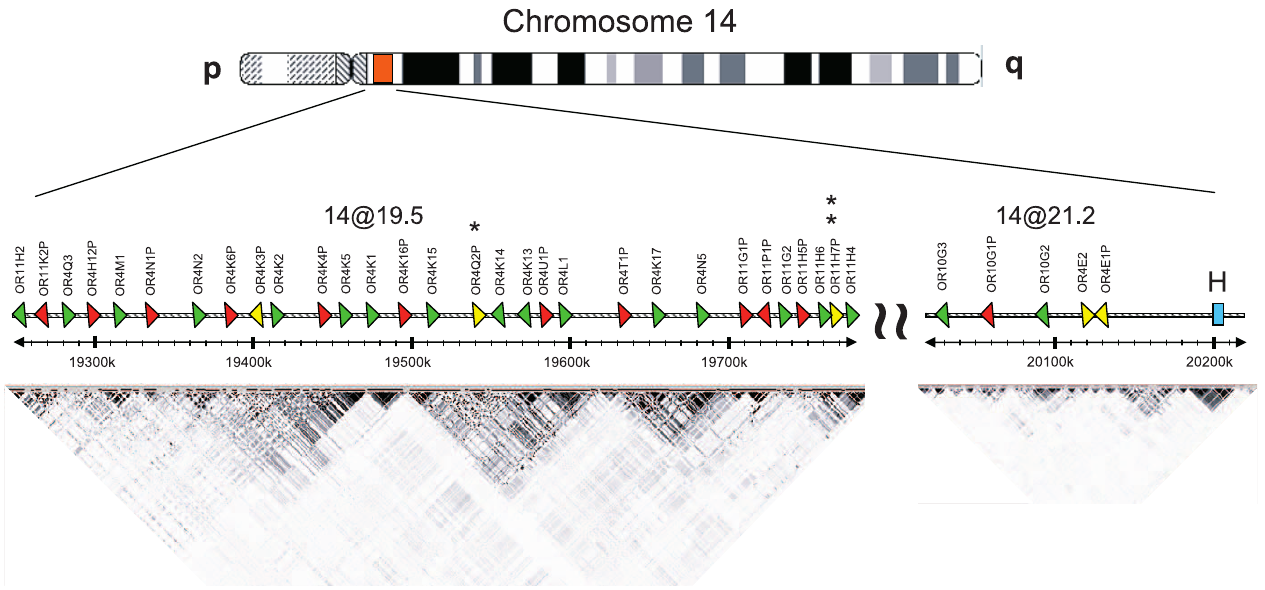
Figure 3. The Genomic Region Associated with IVA Hyperosmia OR genes are represented by red, green, and yellow triangles indicating pseudogenes, intact genes, and SPGs, respectively. The two SPGs showing the strongest association with IVA sensitivity are marked with single and double asterisks. A linkage disequilibrium plot of SNPs with minor allele frequency (cid:3) 5% in HapMap CEU [46] is depicted for this genomic region. The pairwise r 2 values are indicated on a gray scale, with black ¼ 1 and white ¼ 0. This region contains also the putative OR-specific trans -acting enhancer element (H)